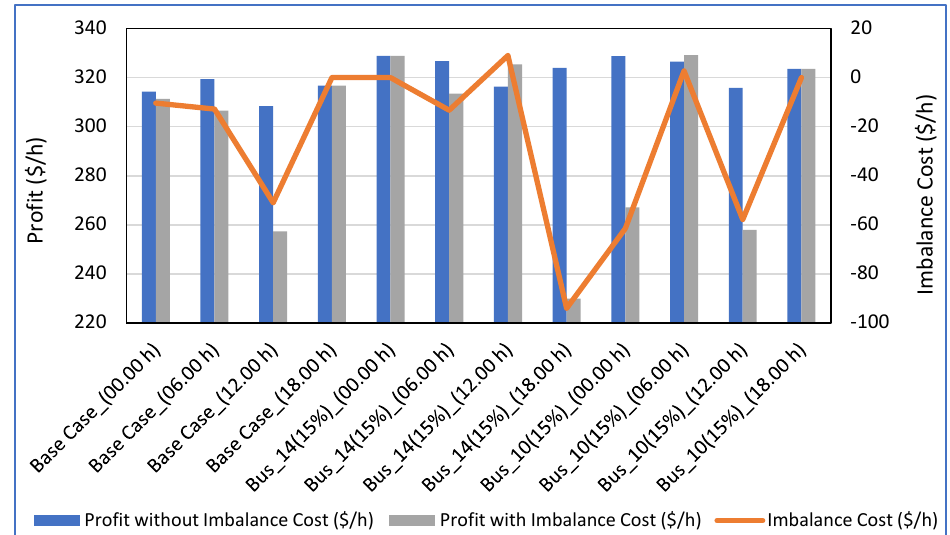
Figure 10. Profit Comparison with Imbalance Cost (Mumbai). Table 7. System profit with different optimization techniques.